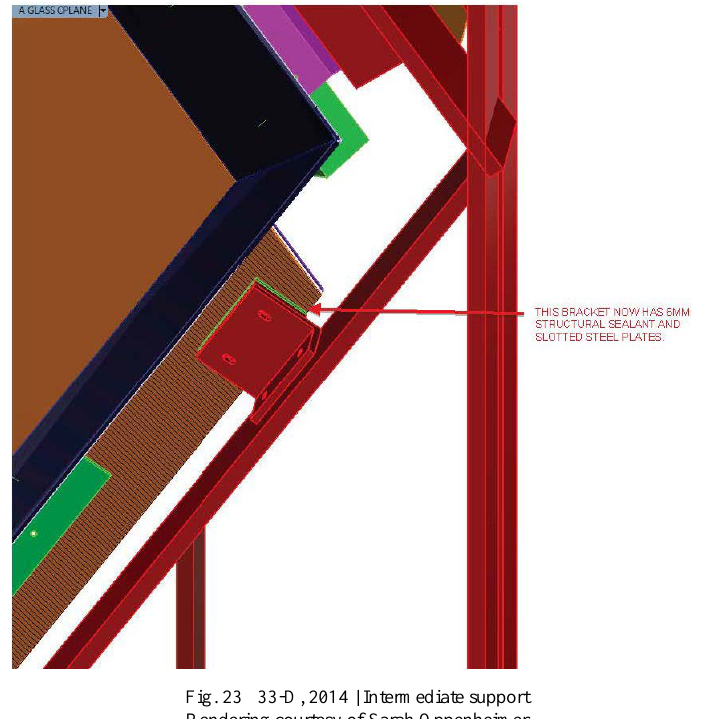
Fig. 23 33-D, 2014 | Intermediate support Rendering courtesy of Sarah